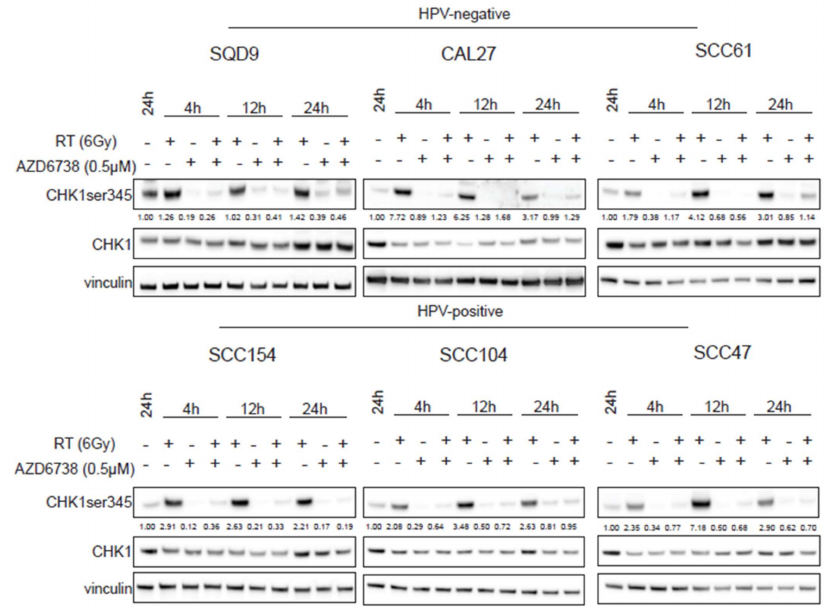
Figure 4. Effect of ATR inhibition on CHK1 activation. HPV-negative (SQD9, CAL27, and SCC61) and HPV-positive (SCC154, SCC104, and SCC47) HNSCC cells were treated with DMSO or AZD6738 (0.5 µ M) 2 h before RT. At the indicated time points, total cell lysates were prepared to perform western blotting for CHK1 ser345 (51 kDa), CHK1 (51 kDa), and vinculin (97 kDa). Densitometry quantification was performed and relative expression levels were corrected to the loading control (vinculin). kDa = molecular weight as determined by the protein